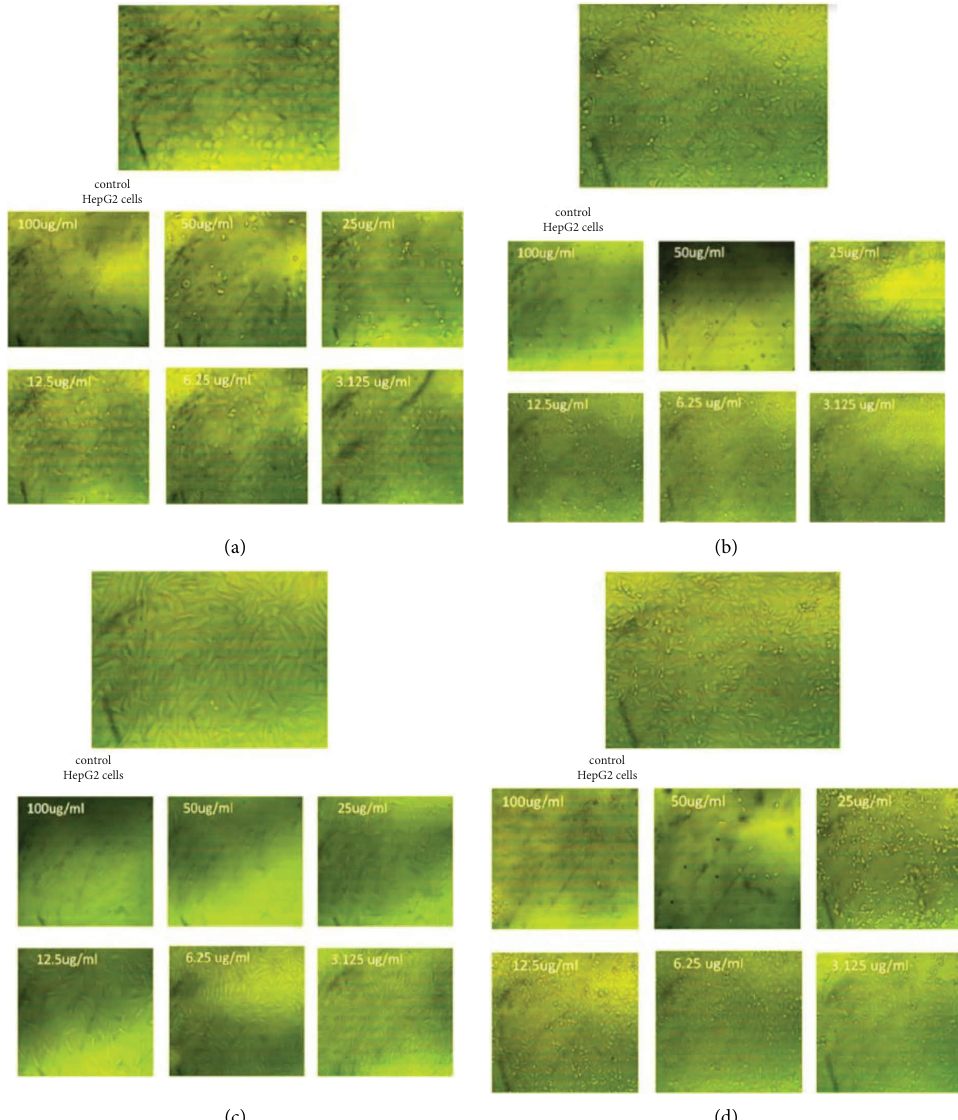
Figure 11: Morphological changes in liver cancer cells (HepG2) treated with diferent concentrations of (a) ligand and (b) Cu(II), (c) Co(II) and (d) Fe(II) complexes for 24